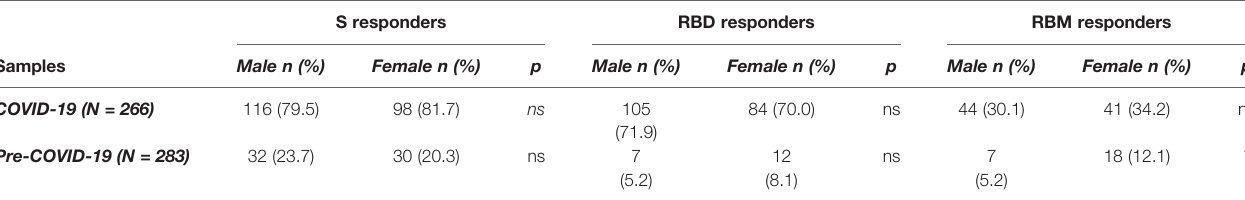
TABLE 2 | Prevalence of antibody responders against S, RBD, and RBM according to gender in COVID-19 and pre-COVID-19 sample groups. S responders RBD responders RBM